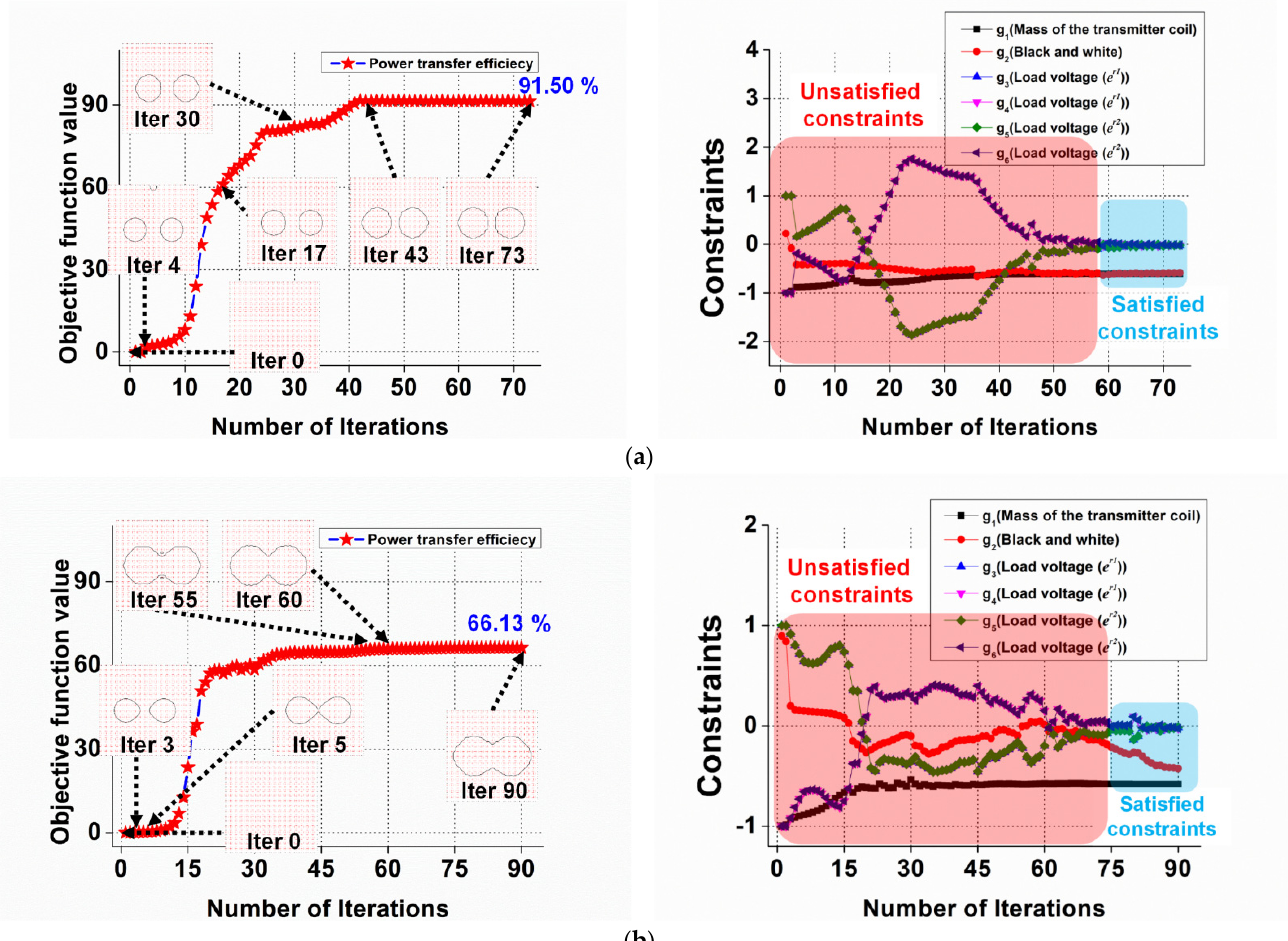
Figure 3. Optimization history of the transmitter coil layout. ( a ) Air gap of 10 mm. ( b ) Air gap of 30 mm.